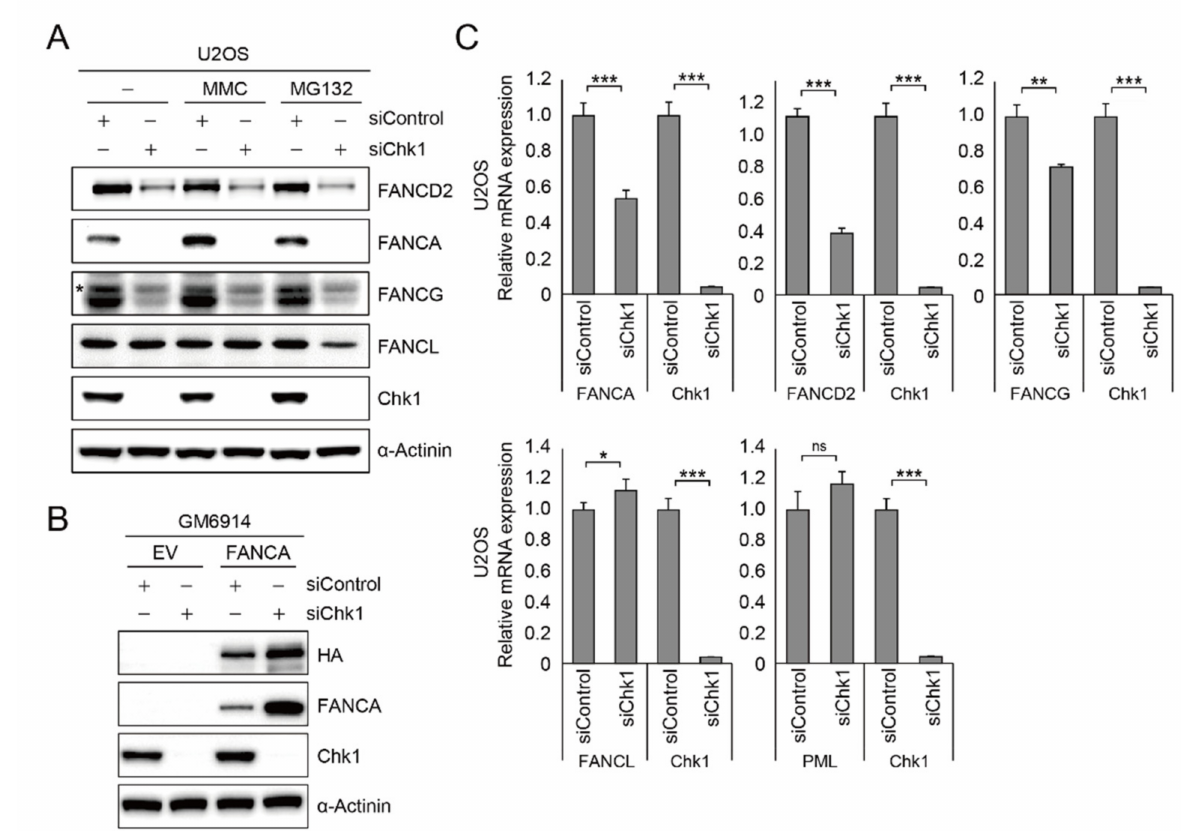
Figure 5. CHK1 is required for the transcriptional regulation of Fanconi anemia core protein and FANCD2 . ( A ) U2OS cells were transfected with siControl or siCHK1 and treated with 1 µ M mitomycin C (MMC) or 10 µ M MG132 for 24 h. Protein expressions were determined from whole cell lysates using antibodies against FANCD2 , FANCA , FANCG , FANCL , and CHK1. The asterisk indicates a cross-reactive artifact. ( B ) After depletion of CHK1, lysates prepared from GM6914/ FANCA cell lines were subjected to immunoblot analysis with HA, FANCA , and CHK1 antibodies. ( C ) After depletion of CHK1, relative mRNA levels of core FA genes, FANCD2 , and CHK1 were assessed through RT-qPCR assay in U2OS cells. Data represent the mean ± SD from three independent experiments (*** p < 0.001; ** p < 0.01; * p < 0.05; ns, not significant ( p >